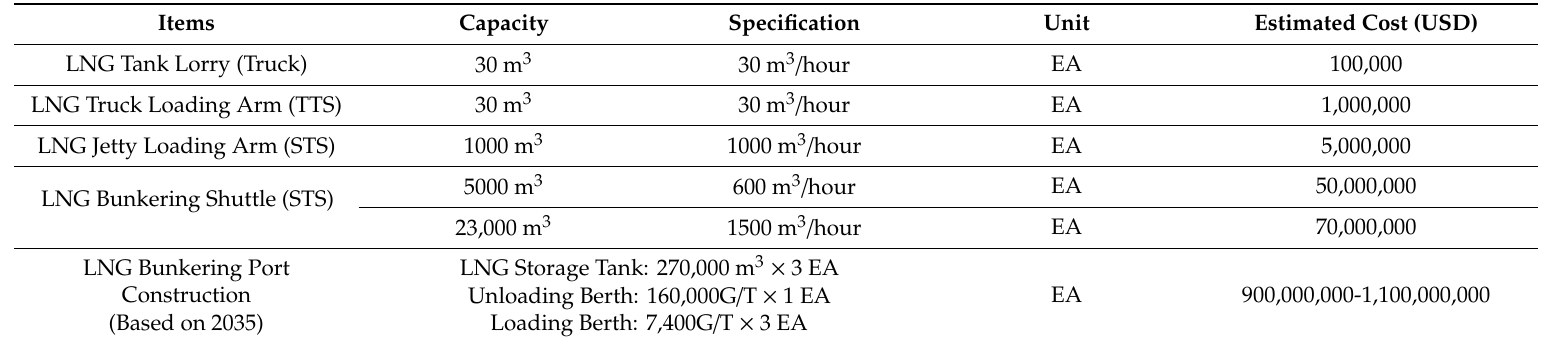
Table A18. Estimated Cost by Items of LNG Bunkering